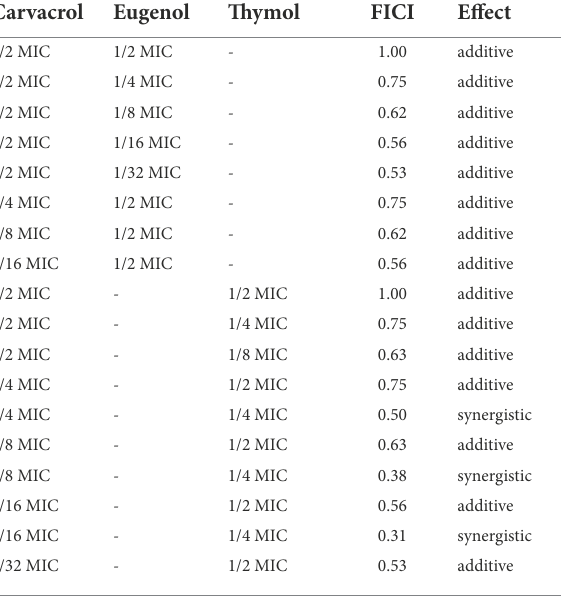
TABLE 4 In vitro effect of carvacrol, eugenol, and thymol combinations on inhibition of Xanthomonas campestris pv. campestris WHRI 3811 growth.